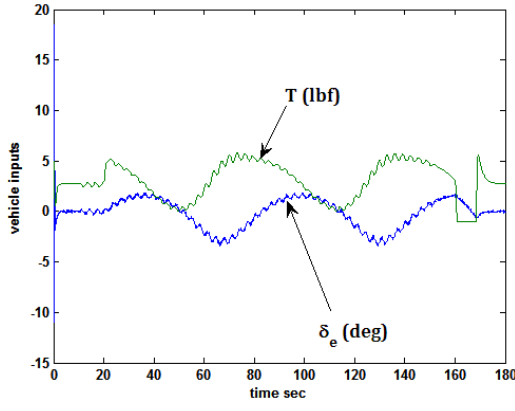
Figure 10. Elevator and thrust inputs for Task 1 with no actuator damage.